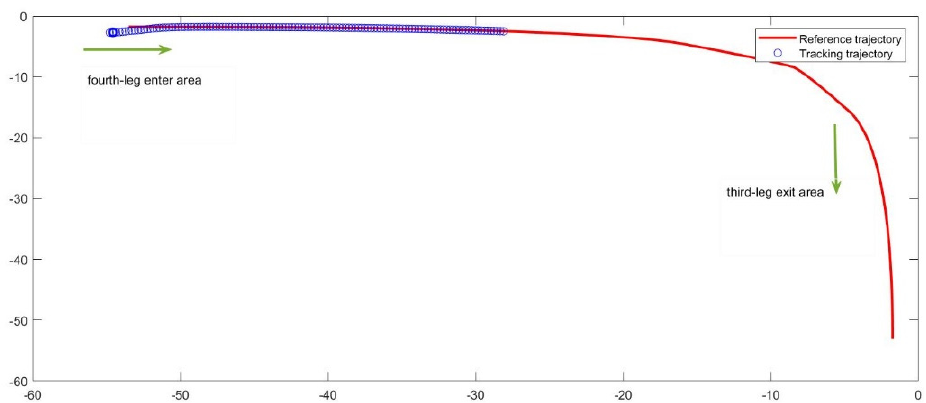
Figure 7. Fourth-leg enter, third-leg exit MPC tracking route. Figure 7 . Fourth-leg enter, third-leg exit MPC tracking route. Table 2. Fourth-leg enter, third-leg exit MPC tracking changing parameters. Table 2. Fourth-leg enter, third-leg exit MPC tracking changing parameters. Case 2 Case 2 Parameters